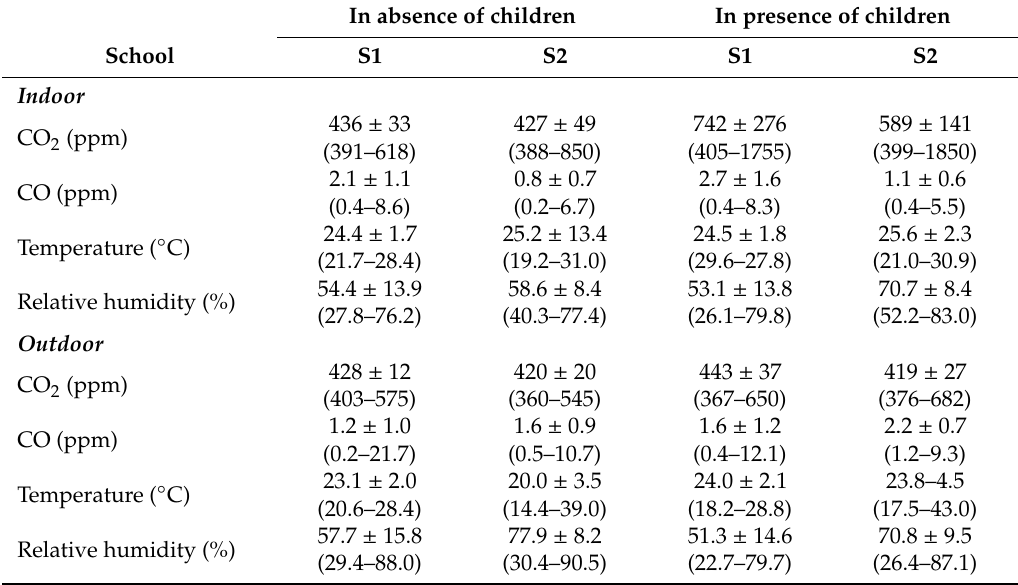
Table 2. Comfort parameters, CO 2 , and CO concentration measured indoors and outdoors at the surveyed preschools (n = 80, average ± standard deviation: